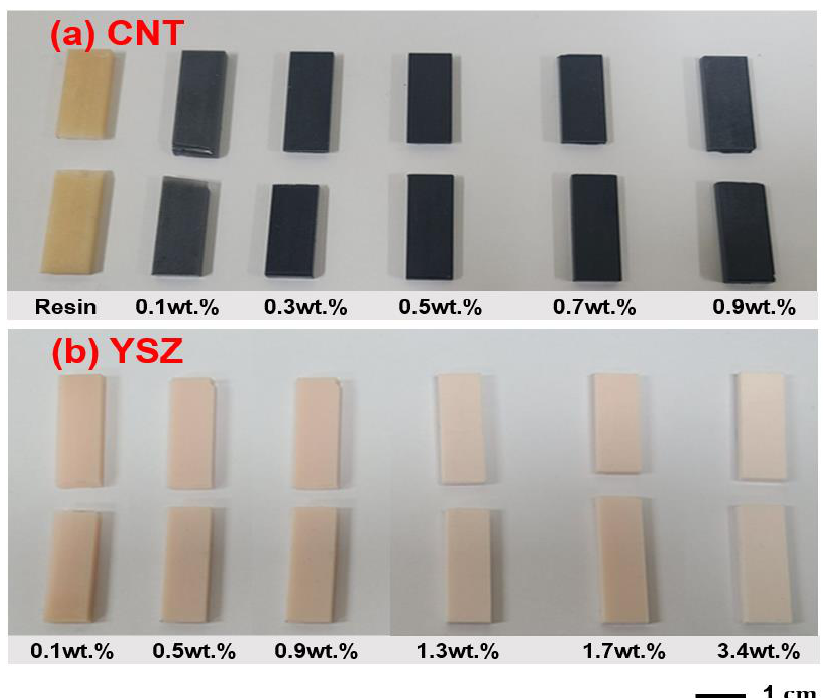
Figure 4. Digital camera images of various ( a ) CNT- and ( b ) YSZ-added bar specimens after three- point bending test.